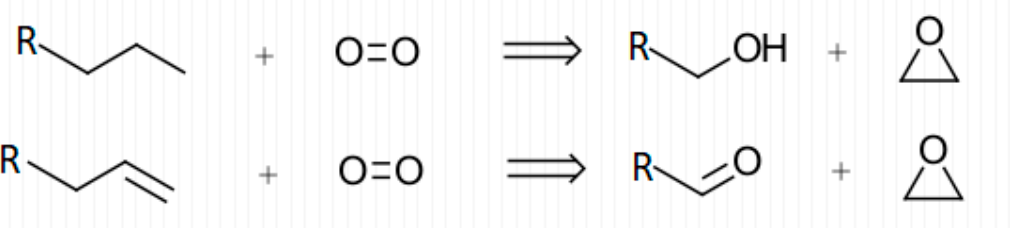
Figure 9. Proposed general reactions for the formation of EtO in canisters.